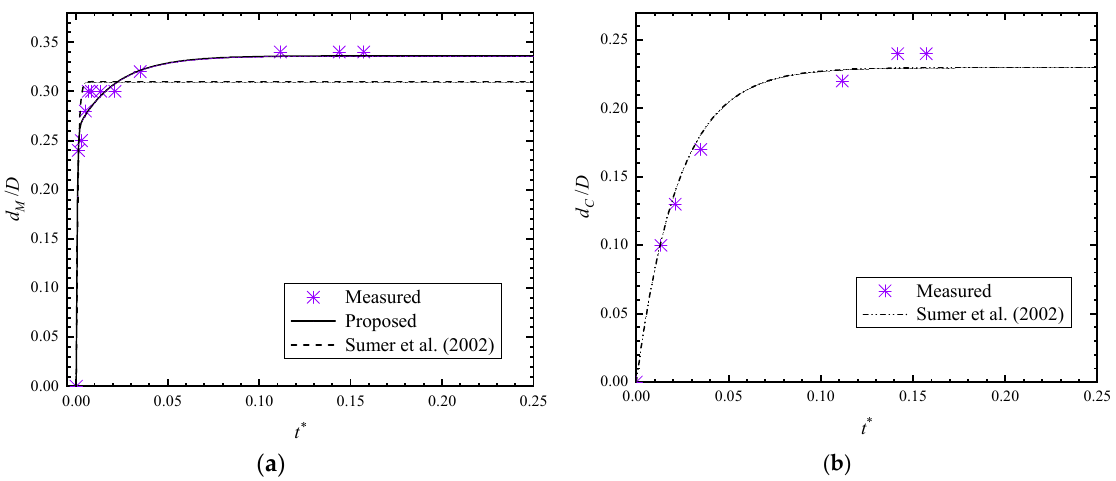
Figure 5. Non-dimensional scour depth evolutions for test 2. ( a ) Upstream corner scour depth evolution; ( b ) Center of upstream scour depth evolution.